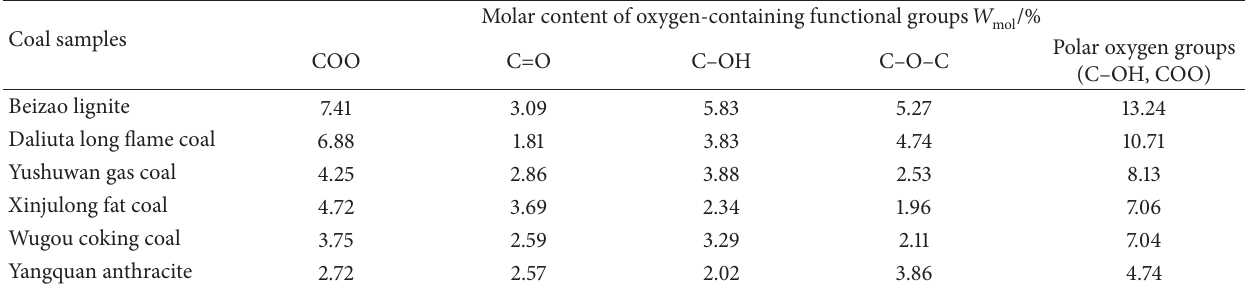
Table 4: Contents of superficial oxygen-containing functional groups of different coal